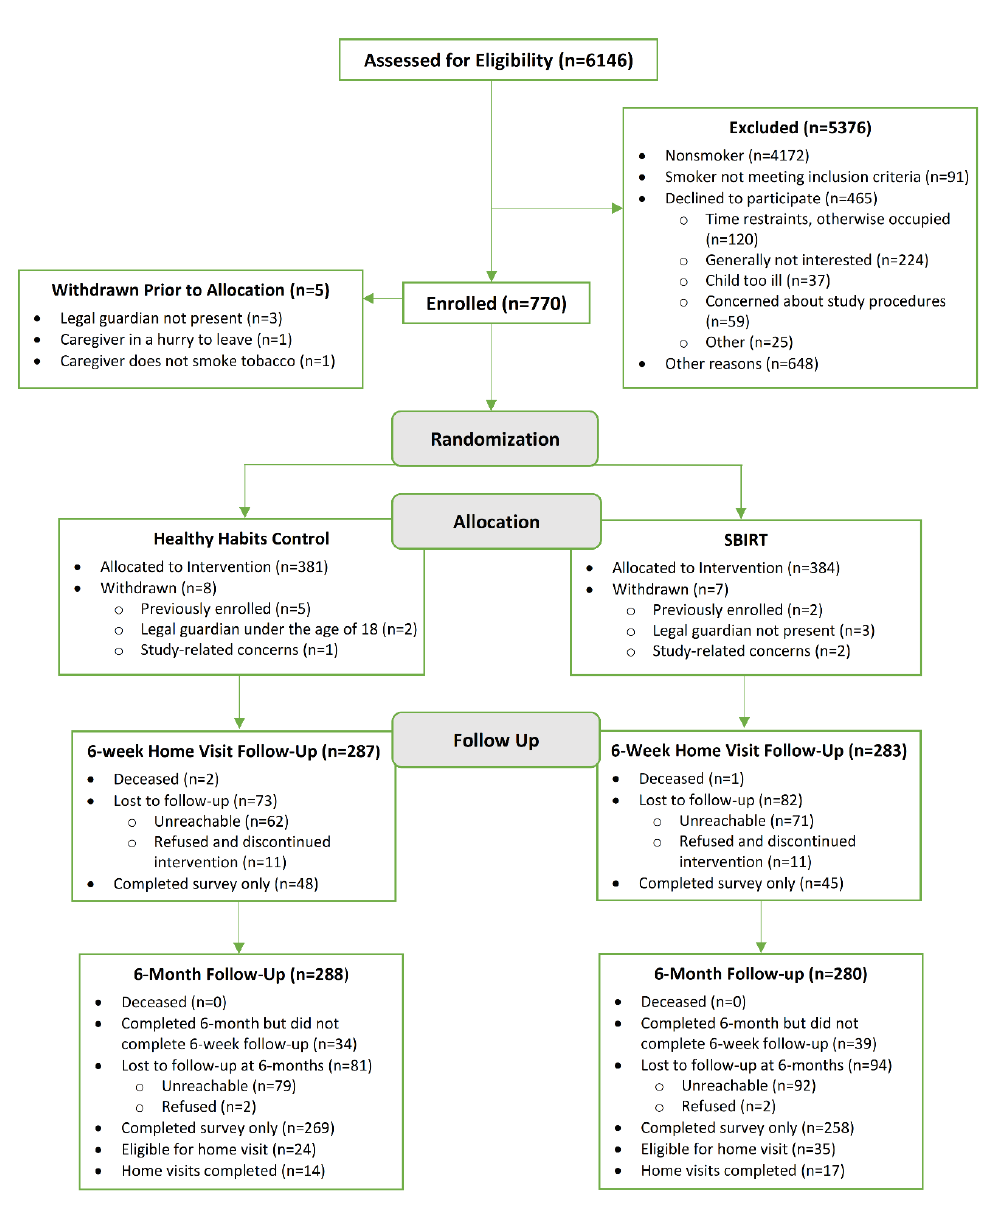
Figure 1. Flow of participants through the study. Table 1. Characteristics of the study population overall and by study group.